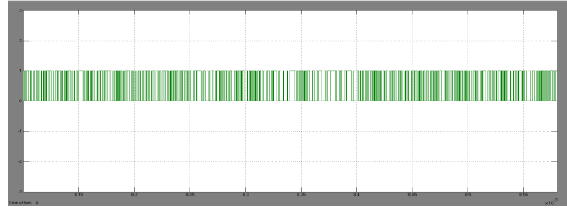
Fig. 12. The Output Signal PN Sequence Generator.